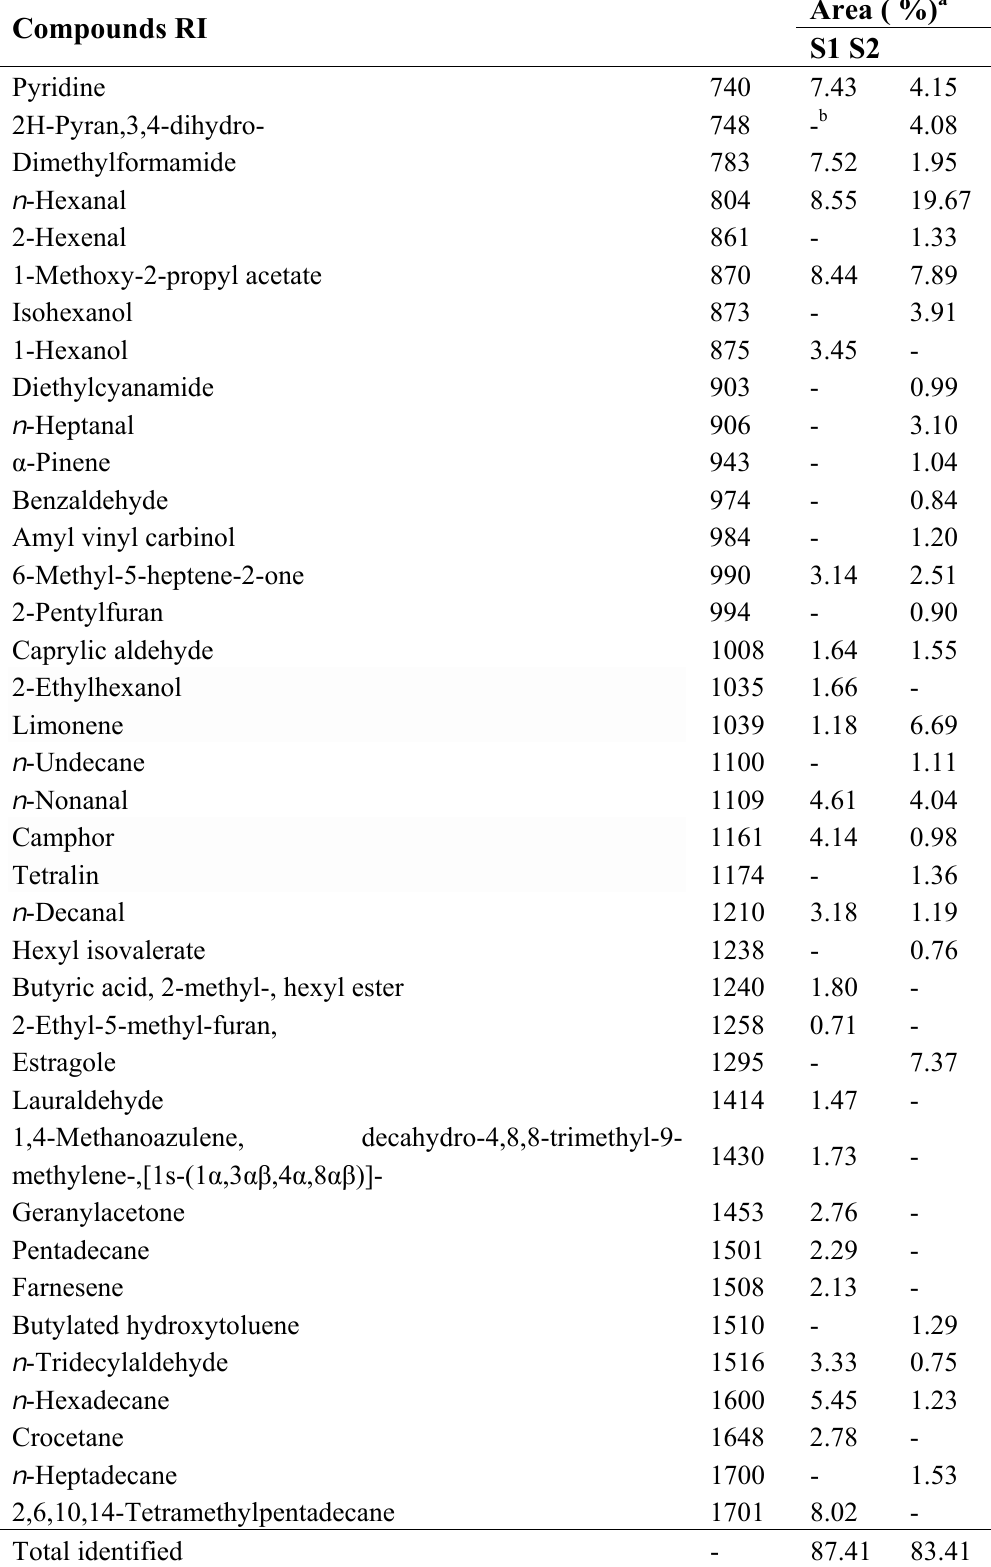
Table 1. Chemical composition of two samples of Rh. giganteum (Bryaceae) and their corresponding retention indices